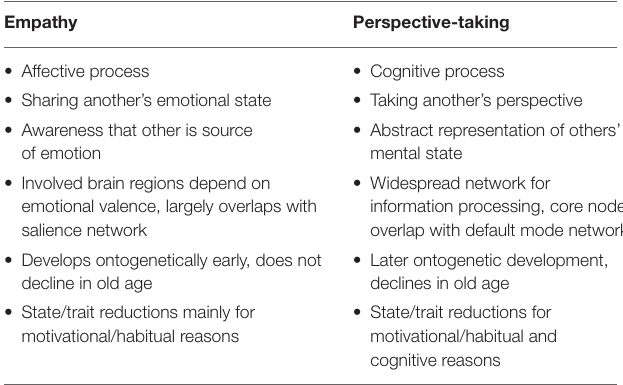
TABLE 1 | Summary of the conceptual and empirical dissociation of empathy and perspective-taking.